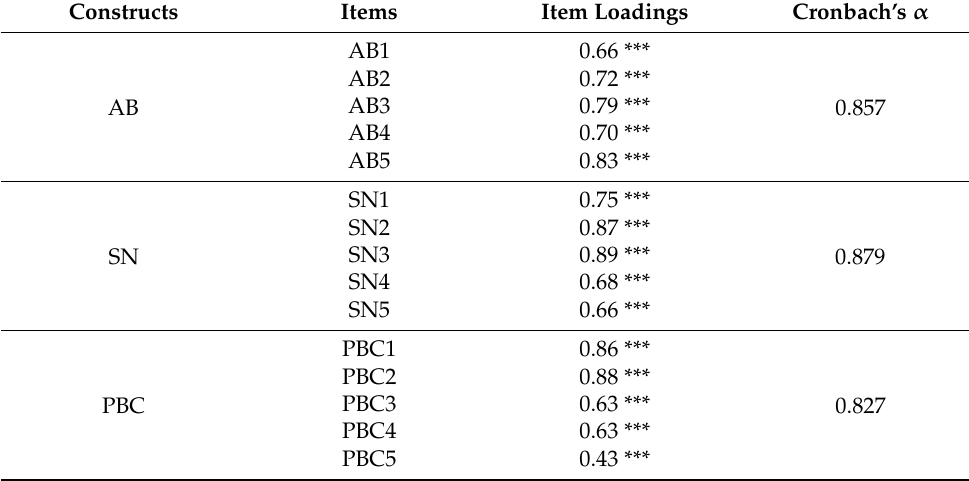
Table 2. Testing coefficients in the measurement